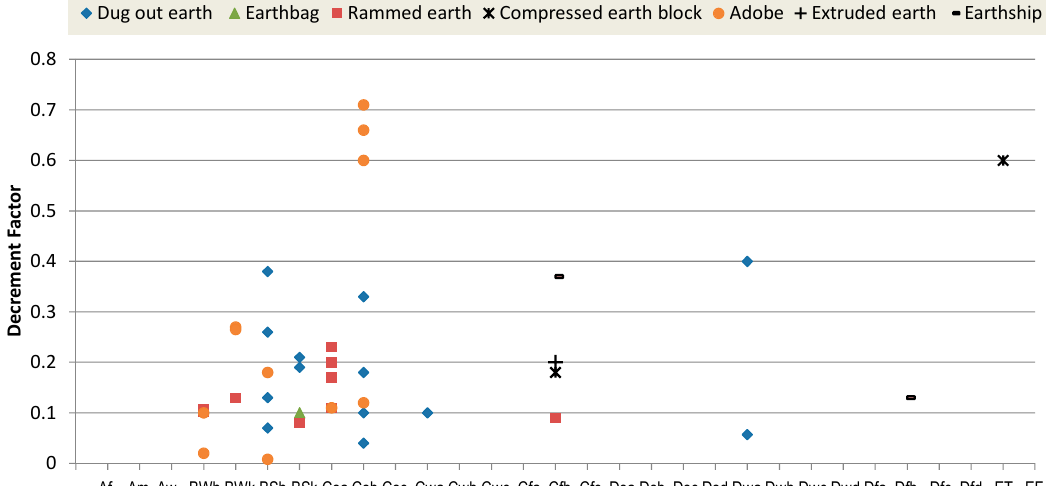
Figure5. Decrement factor in function of the wall thickness.